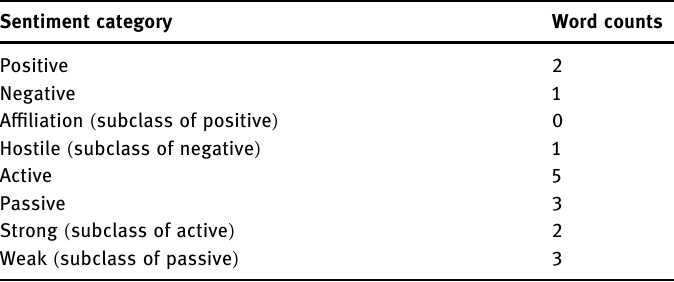
Table A1: Frequency ( word count ) of words in di ff erent sentiment